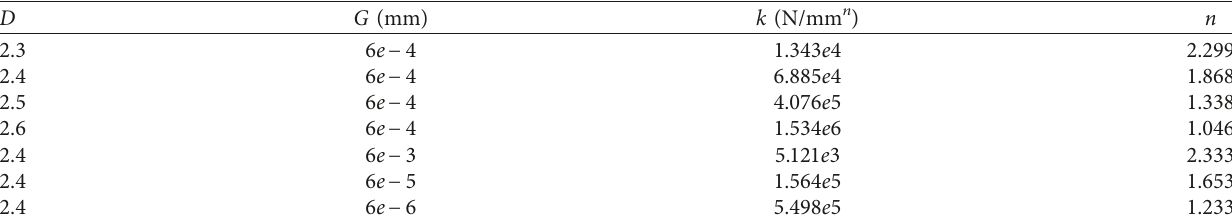
Table 2: The k and n values for different fractal